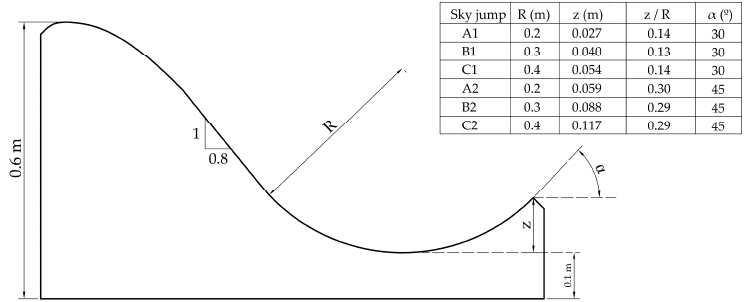
Figure 7. Geometrical configuration of the physical models: radius of curvature R , depth of the flip-bucket z , flip angle α , and parameter z / R are variable parameters.